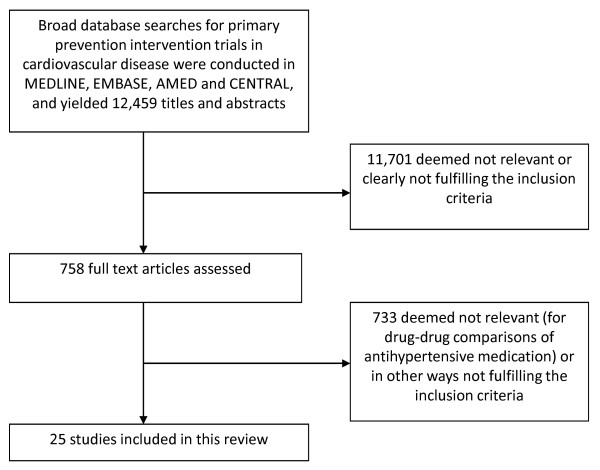
Review flowchart.